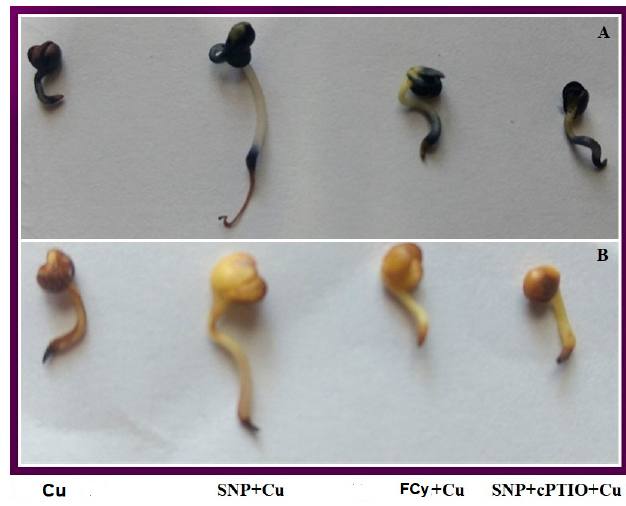
Figure 5. Accumulation of superoxide ion (O 2 − ) using NBT staining, and ( A ) H 2 O 2 using DAB staining ( B ) in germinating seeds of Indian mustard ( Brassica juncea L.) pre-treated with water, SNP, FCy (SNP analogue) or SNP + cPTIO (cPTIO as a specific NO-scavenger), exposed to 3.0 mM Cu for 3 days.